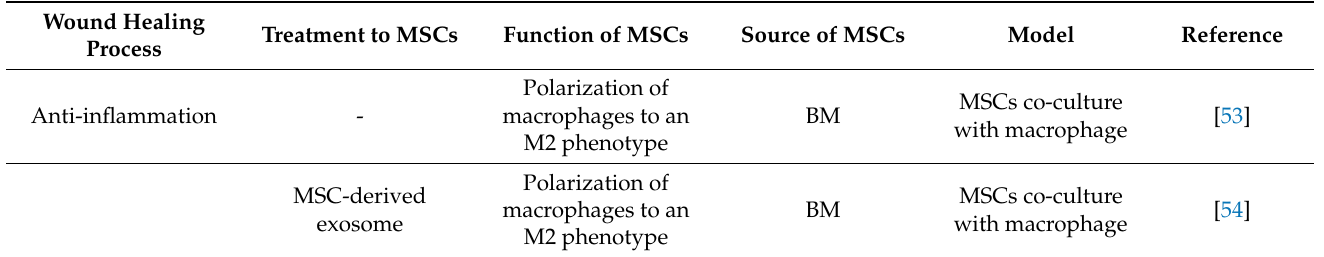
Figure 2. MSCs healing mechanism in skin regeneration and rejuvenation. Table 1. Applications of mesenchymal stem cells (MSCs) in wound healing.